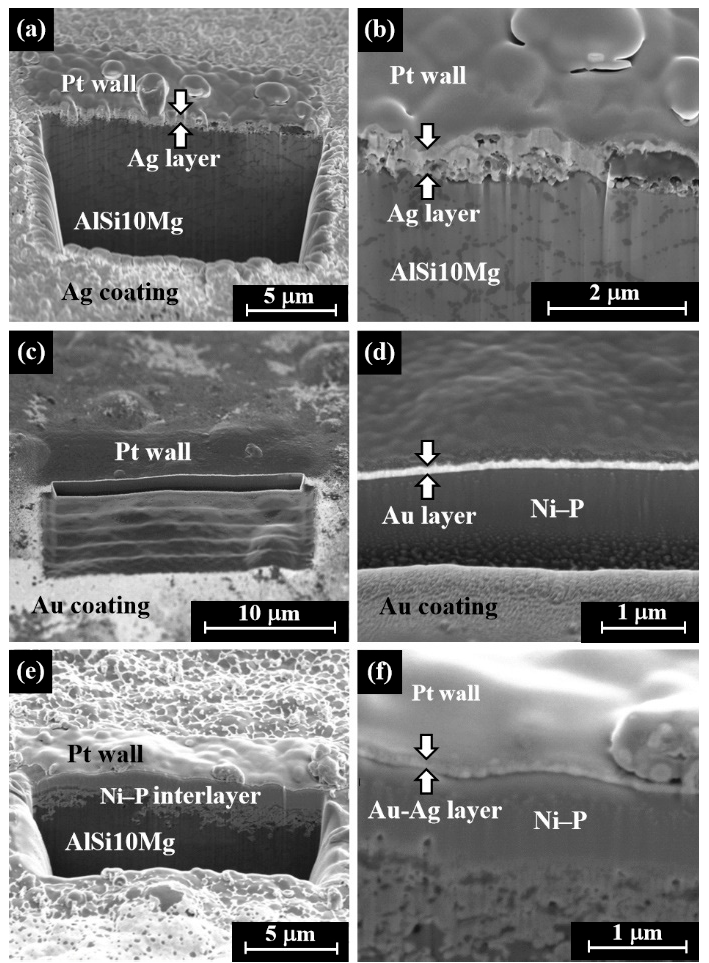
Figure 8. SEM images of the laboratory-plated AlSi10Mg sample following selective material milling by the focused ion beam (FIB) technology starting from the specimen surface: ( a , b ) cross-section of the Ag-plated sample, showing the hole cut by FIB, the Pt wall behind the hole, and the printed substrate with the Ag layer on top; ( c , d ) a cross-section of the Au-plated sample, showing the hole cut by FIB, the Pt wall, the substrate, the ≈ 1 µm Ni–P ( ≈ 5 wt.% P) layer, and the Au layer on top (white layer); ( e , f ) cross-section of the electrum-plated sample, showing the hole cut by FIB, the Pt wall, the substrate, the Ni–P layer, and the Au–Ag layer on top.